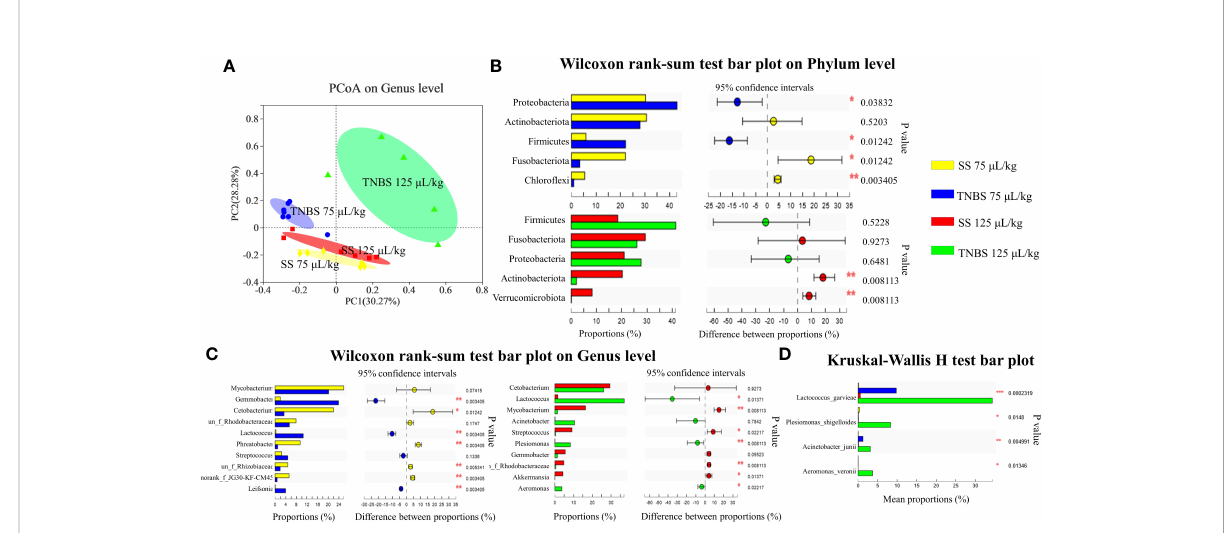
FIGURE 3 The effect of TNBS on the intestinal microbiota. (A) The principal co-ordinates analysis (PCoA) on genus level. (B) Relative abundance on Phylum level (top 5). (C) Relative abundance on Genu level (top 10). (D) Relative abundance of 4 pathogenic bacteria. N = 6 at least. P value was calculated by Student ’ s t tests. * P < 0.05, ** P < 0.01, *** P < 0.001 compared with PBS groups.